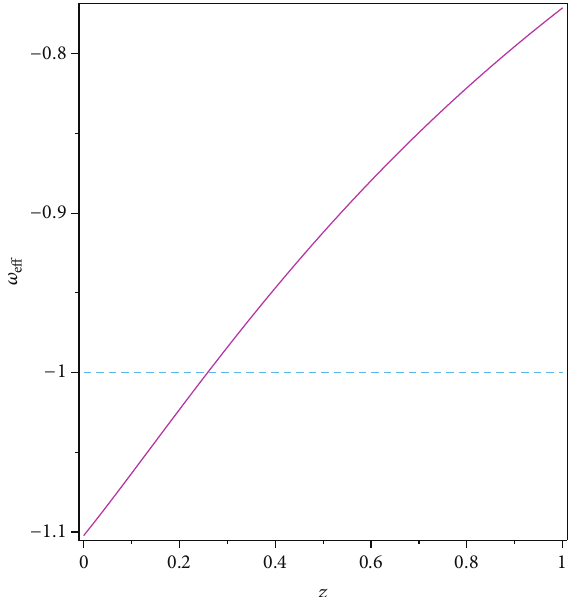
Figure 7: The evolution of the effective equation of state parameter of the hybrid chameleon model versus the redshift for the case that 𝑚 = 1.2 , 𝑛 = 0.7 , 𝛽 = 1 , and 𝜔 = 0 .